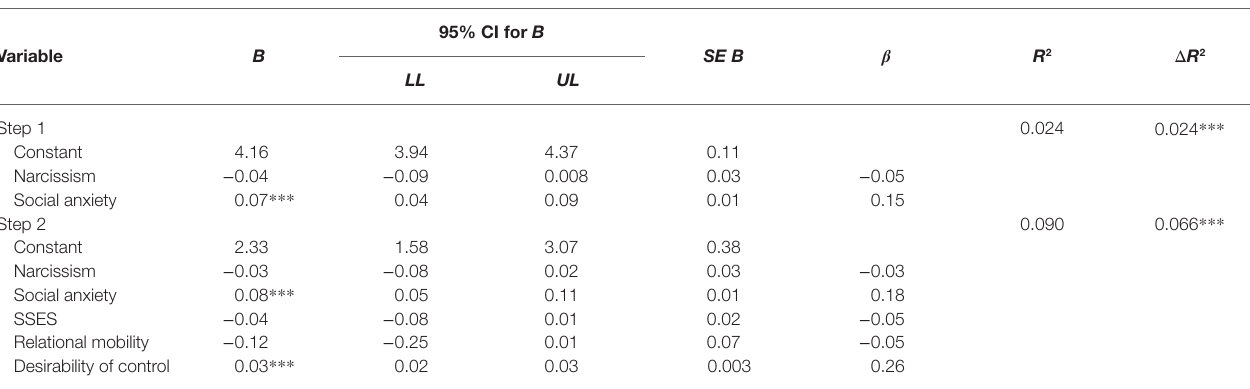
TABLE 2 | Hierarchical regression results for attitudes toward singlehood ( N = 1,108).